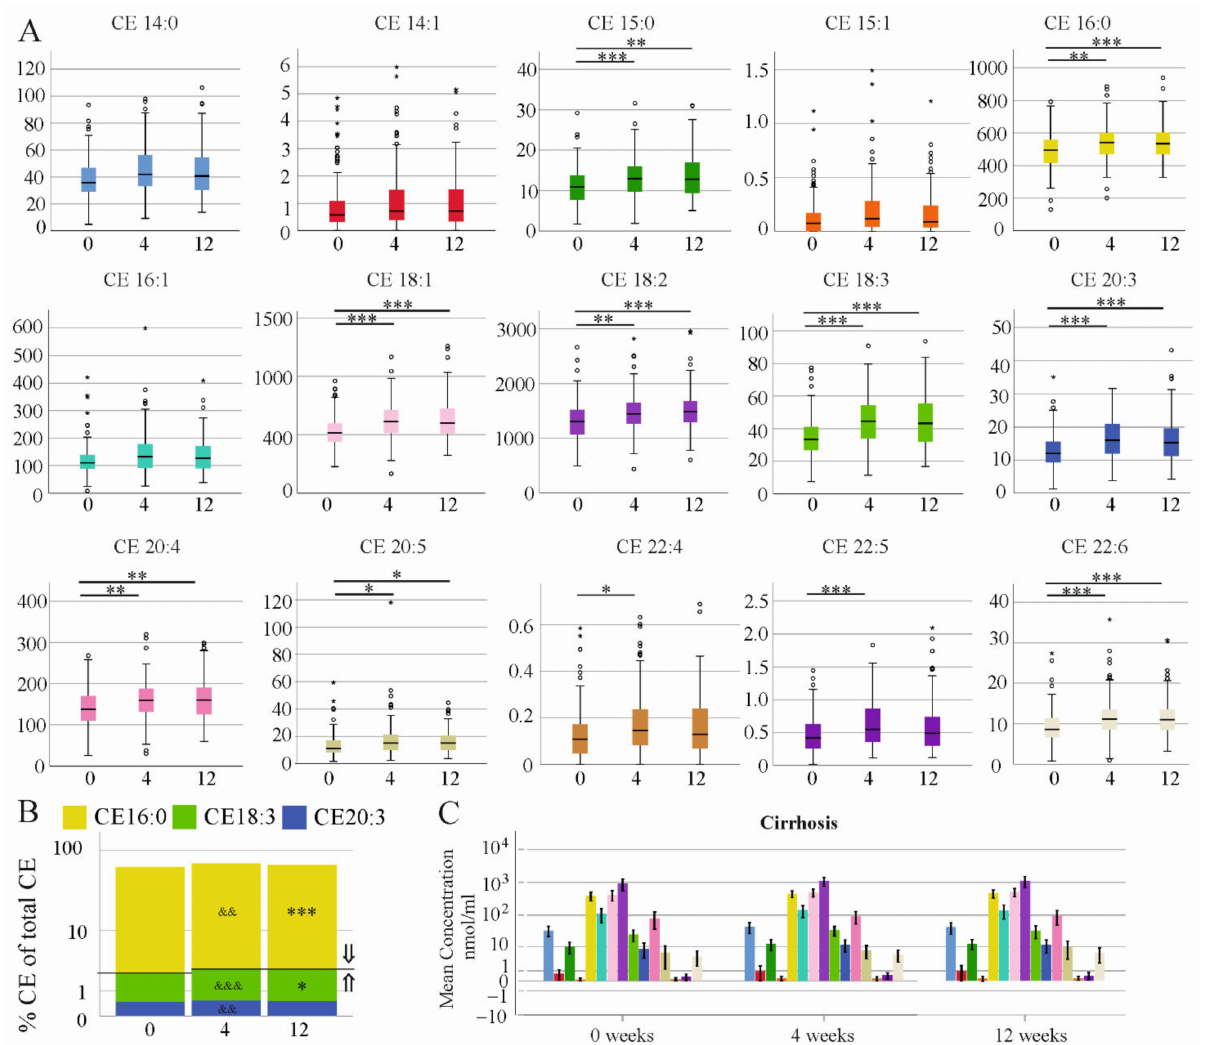
Figure 6. Cholesteryl ester (CE) species during the study. ( A ) Concentrations in serum of patients without cirrhosis diagnosed by ultrasound before therapy, and at 4 and 12 weeks after therapy start. Small circles or asterisks above or below the boxes mark the outlier. * p < 0.05, ** p < 0.01, *** p < 0.001. ( B ) % CE of total CEs in the serum of patients without cirrhosis diagnosed by ultrasound before therapy, and at 4 and 12 weeks after therapy start. ⇑ higher compared to 0 weeks, ⇓ lower compared to 0 weeks (&& p < 0.01, &&& p < 0.001 for comparison of 0 and 4 weeks and * p < 0.05, *** p < 0.001 for comparison of 0 and 12 weeks). ( C ) Concentrations in the serum of patients with cirrhosis diagnosed by